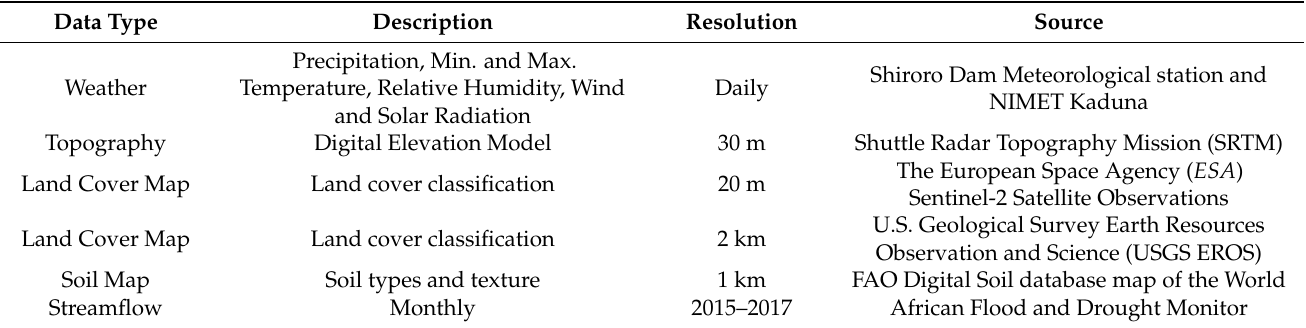
Table 1. SWAT model input data.